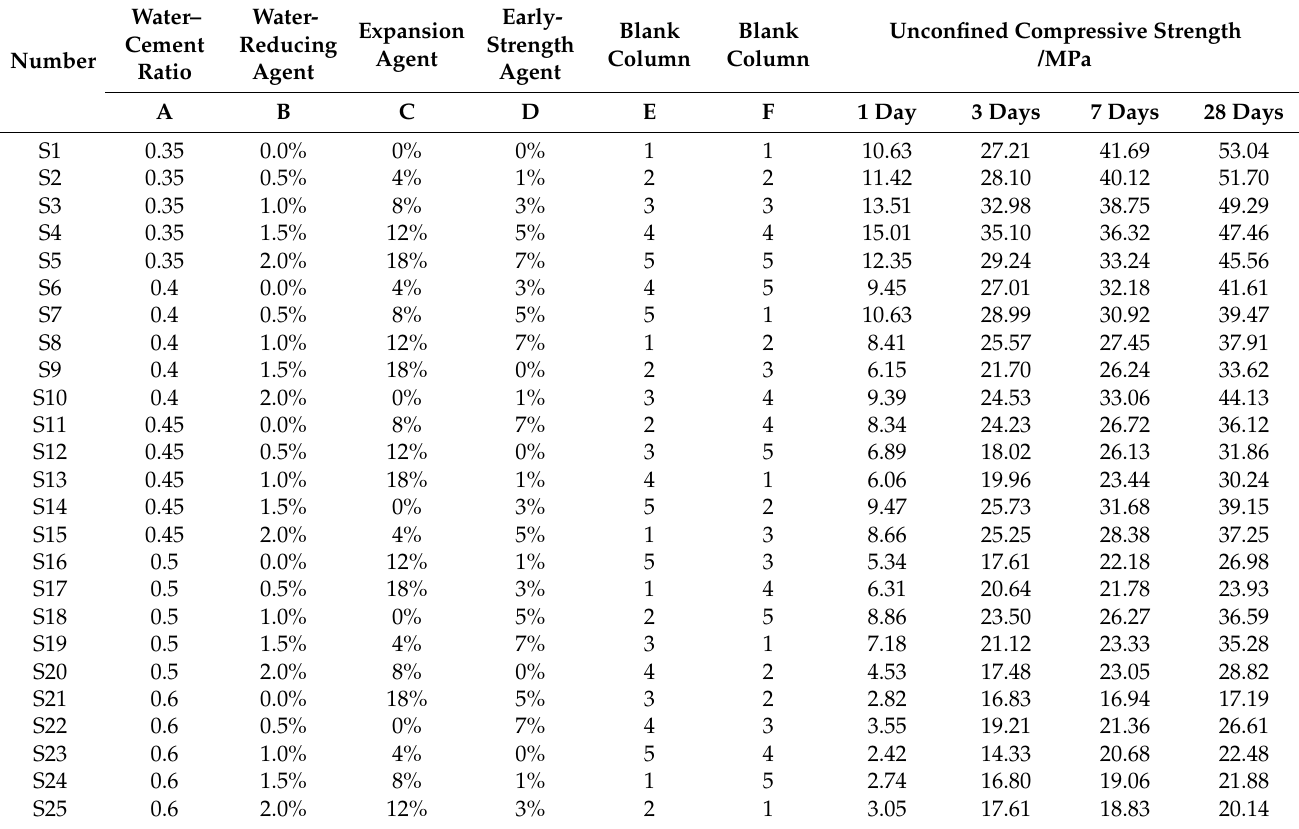
Table 2. Orthogonal tests scheme and test results.